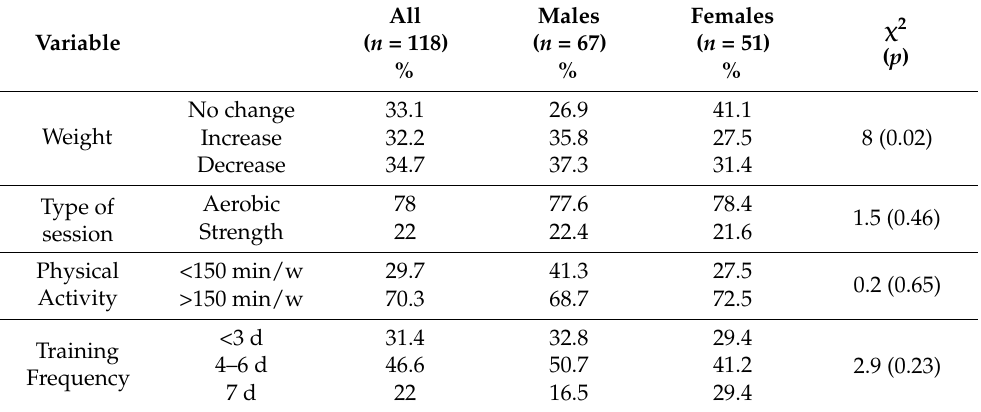
Table 1. Physical activity